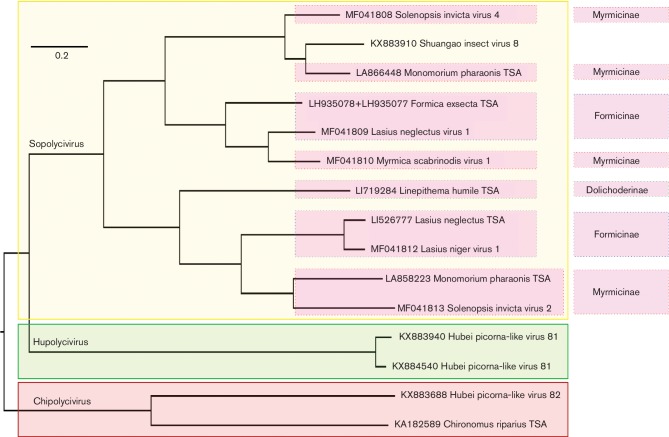
Phylogenetic tree of the proposed family Polycipiviridae. ORF5 amino acid sequences were aligned with muscle, and a Bayesian Markov chain Monte Carlo-based phylogenetic tree was produced with MrBayes. All posterior probabilities were equal to 1.00. The tree was mid-point rooted and visualized with FigTree. TSA indicates sequences obtained from the NCBI Transcriptome Shotgun Assembly database. Proposed Polycipiviridae genera – Chipolycivirus, Hupolycivirus and Sopolycivirus – are delineated with boxes. For sopolyciviruses, the host ant subfamilies are indicated on the right-hand side.